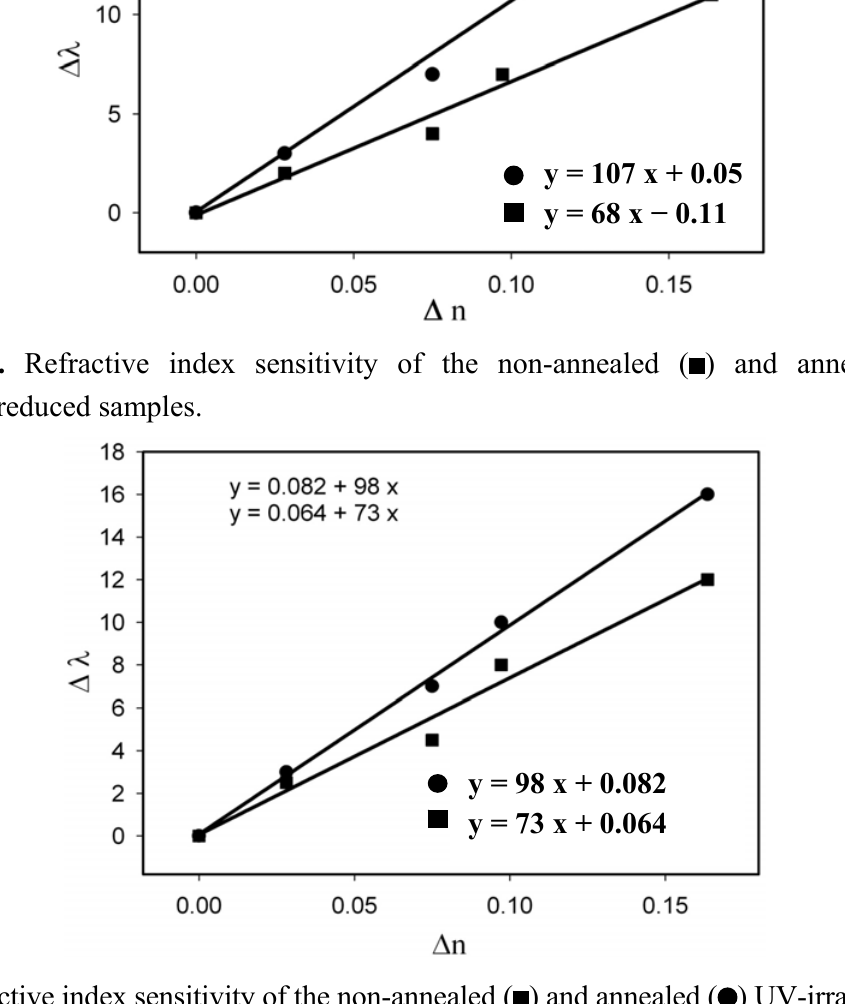
Figure 11. Refractive index sensitivity of the non-annealed ( ) and annealed ( ) UV-irradiated